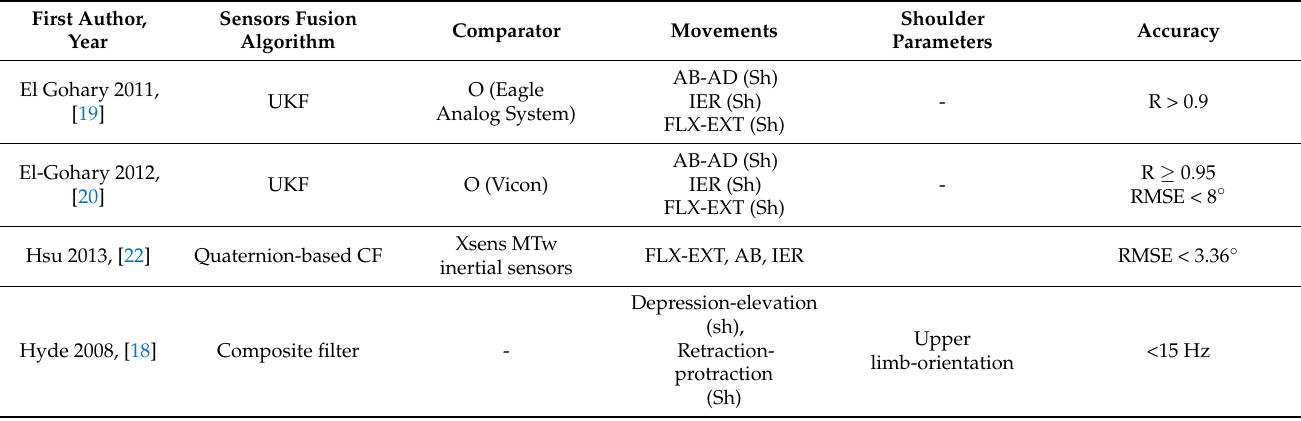
Table 2. Sensors’